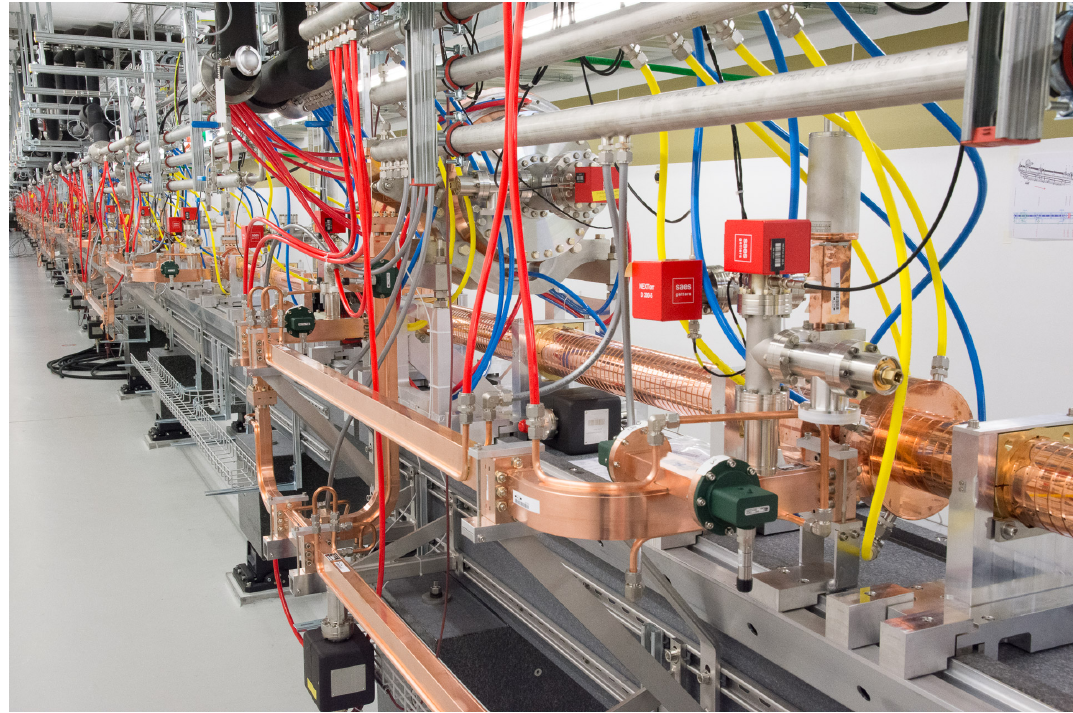
Figure 2. The C-band accelerating modules of linac